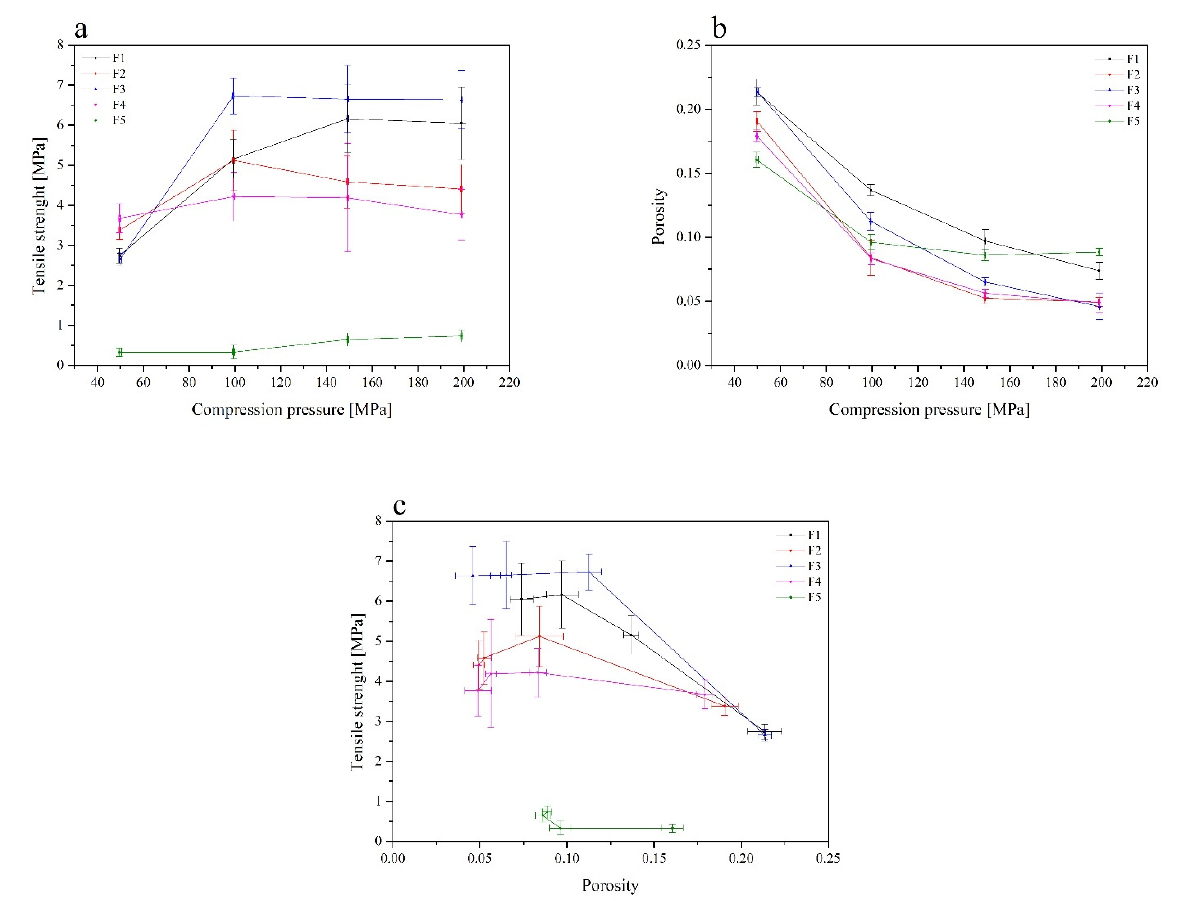
Figure 6. Tabletability ( a ), compressibility ( b ) and compactibility ( c ) profiles of the RSV cyclodextrin systems (F1-RSV/ α -CD 1:1 DM, F2-RSV/ β -CD 1:1 DM, F3-RSV/ γ -CD 1:1 DM, F4-RSV/HP- β -CD 1:1 DM, F5-RSV/HP- β -CD 1:1